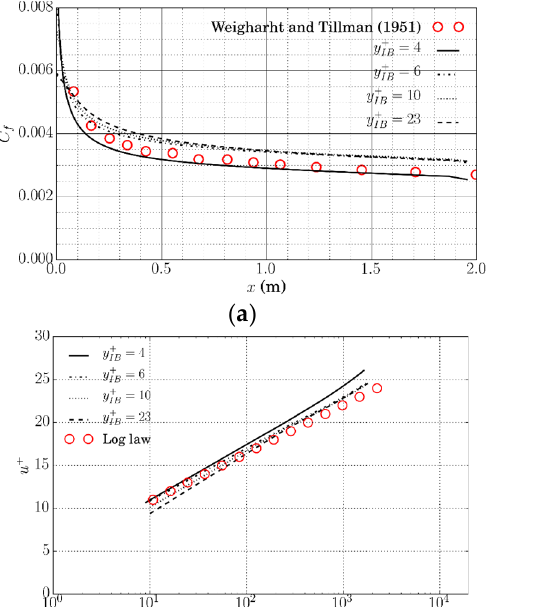
Table 1. Modified wall model performances on a single-core computer.